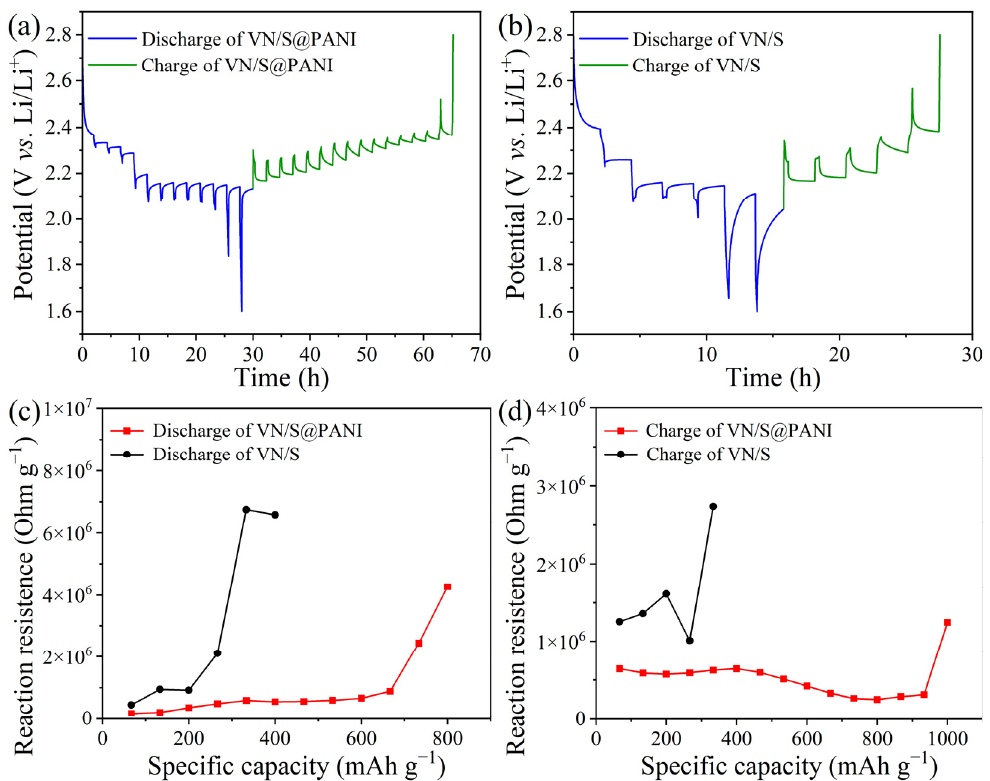
Figure 9. GITT time-potential distribution of ( a ) VN/S and ( b ) VN/S@PANI in discharging and charging. In situ reaction impedances of VN/S and VN/S@PANI during ( c ) discharge and ( d )